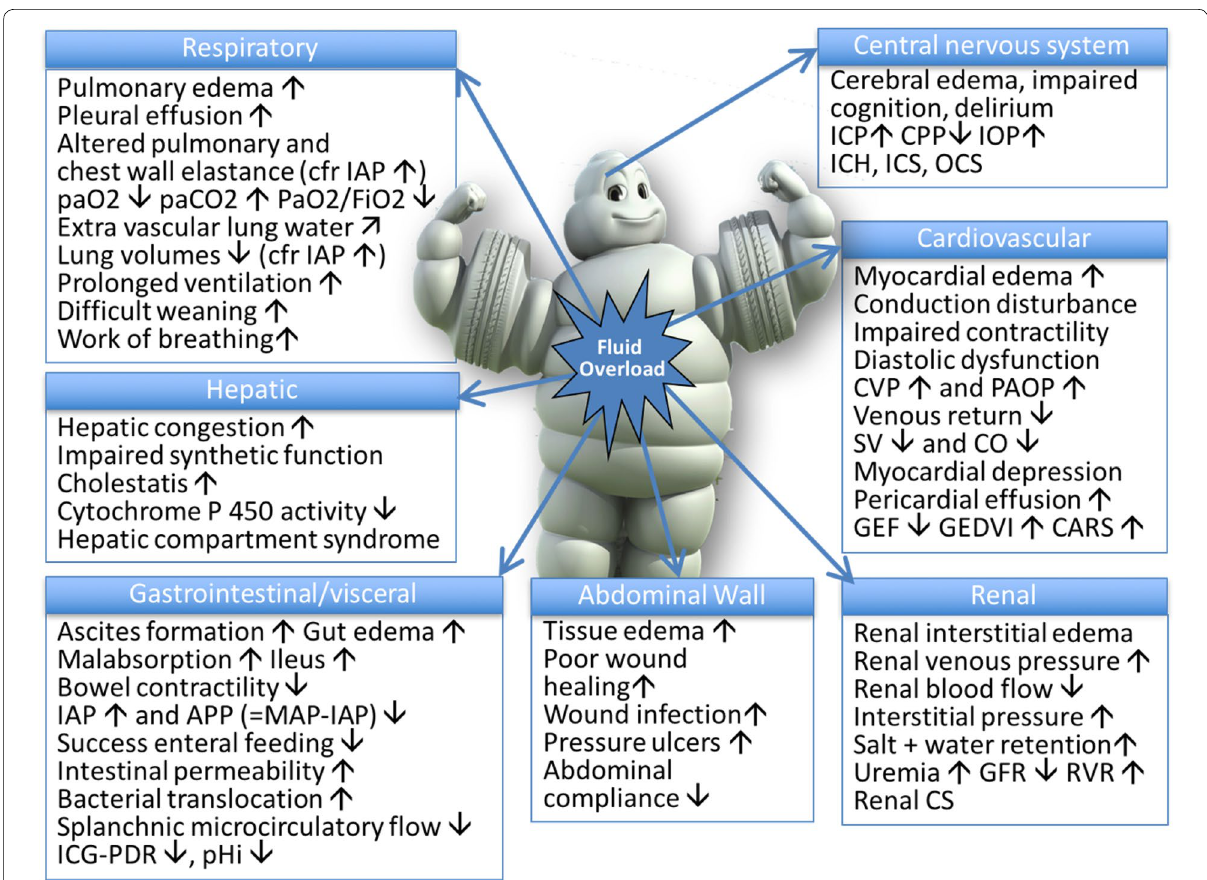
Fig. 2 Potential consequences of fluid overload on end‑organ function. Adapted from Malbrain et al. with permission [1, 2]. APP: abdominal perfu‑ sion pressure, IAP: intra‑abdominal pressure, IAH: intra‑abdominal hypertension, ACS: abdominal compartment syndrome, CARS: cardio‑abdominal‑ renal syndrome, CO: cardiac output, CPP: cerebral perfusion pressure, CS: compartment syndrome, CVP: central venous pressure, GEDVI: global enddiastolic volume index, GEF: global ejection fraction, GFR; glomerular filtration rate, ICG‑PDR: indocyaninegreen plasma disappearance rate, ICH: intracranial hypertension, ICP: intracranial pressure, ICS: intracranial compartment syndrome, IOP: intra‑ocular pressure, MAP: mean arterial pressure, OCS: ocular compartment syndrome, PAOP: pulmonary artery occlusion pressure, pHi: gastric tonometry, RVR: renal vascular resistance, SV: stroke